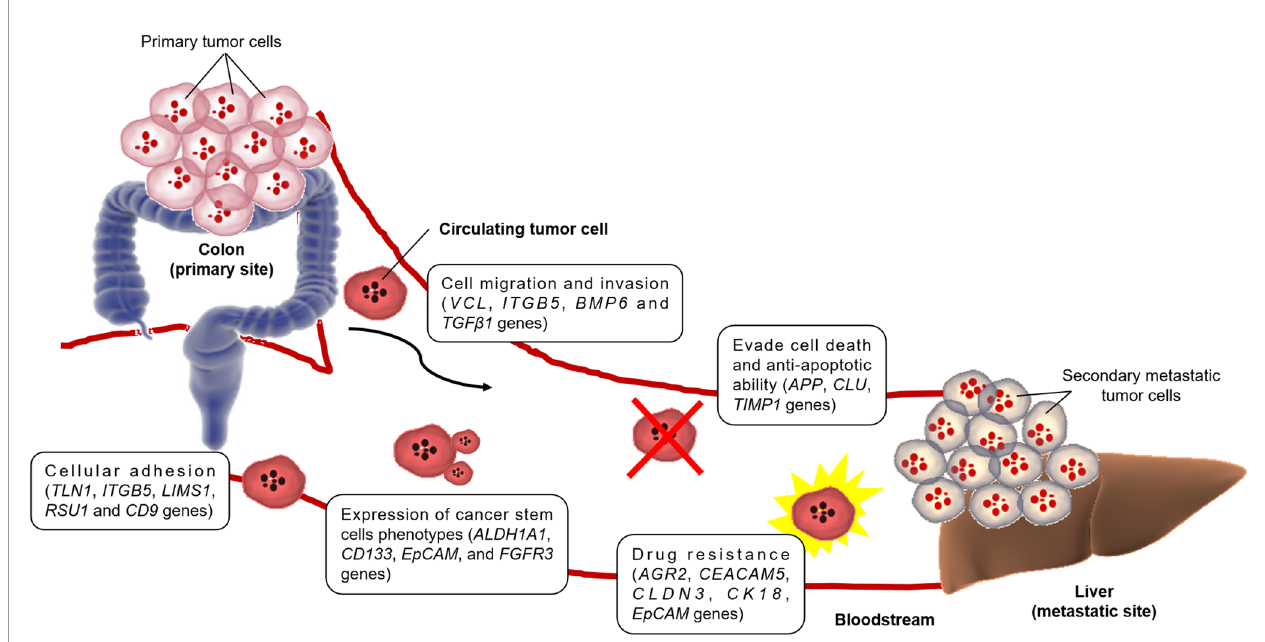
FIGURE 1 | Figure representing mechanisms of distant metastatic colonization of CTCs and the genes involved in CRC (Barbazán et al., 2012; Grillet et al.,